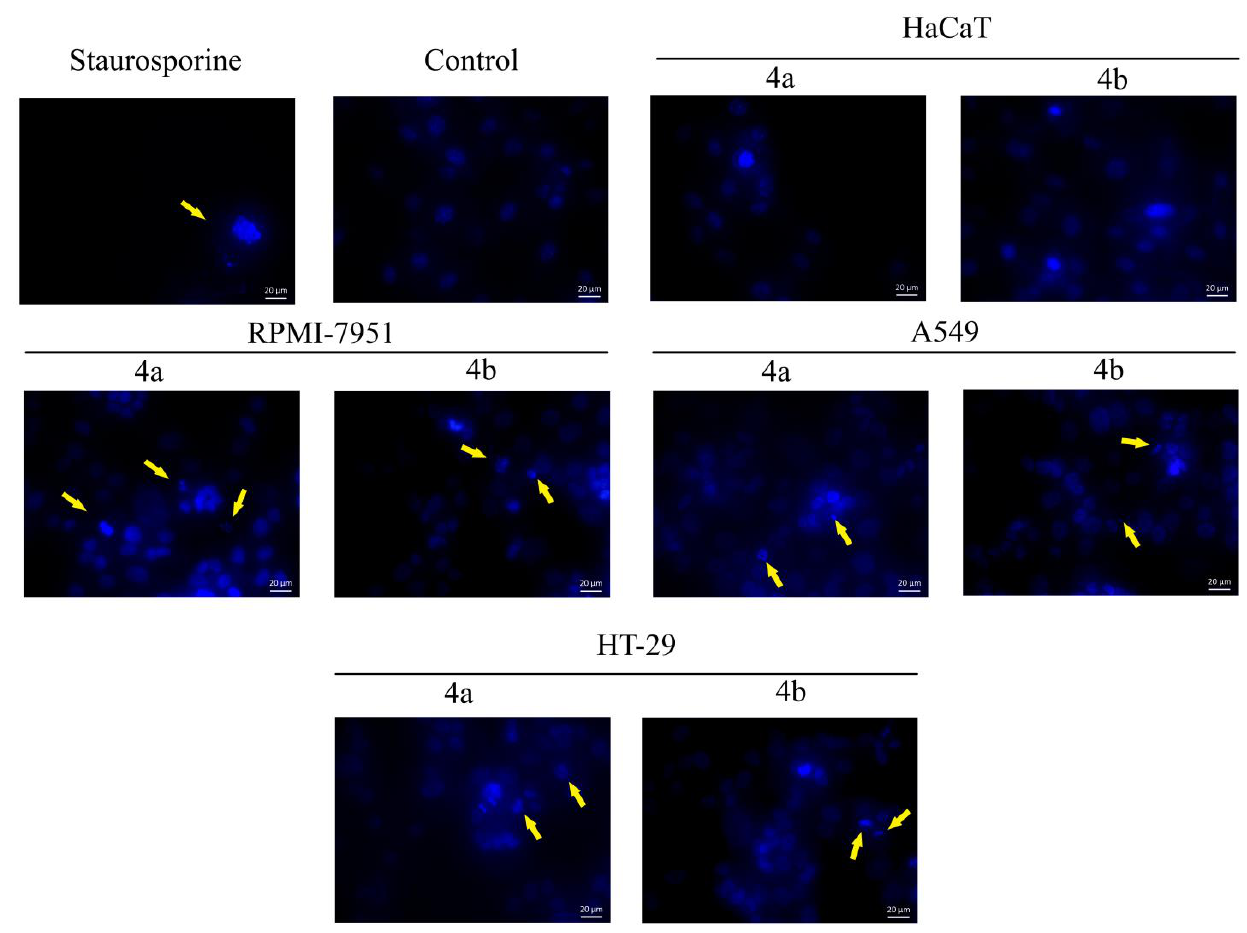
Figure 5. Morphological observation of HaCaT, RPMI−7951 , A549, and HT−29 cell lines using DAPI assay, following treatment with 4a and 4b (tested at their respective IC 50 ) for 48 h. Positive control for nuclei apoptotic changes: staurosporine (5 μM). The apoptotic morphological changes are indicated by yellow arrows.